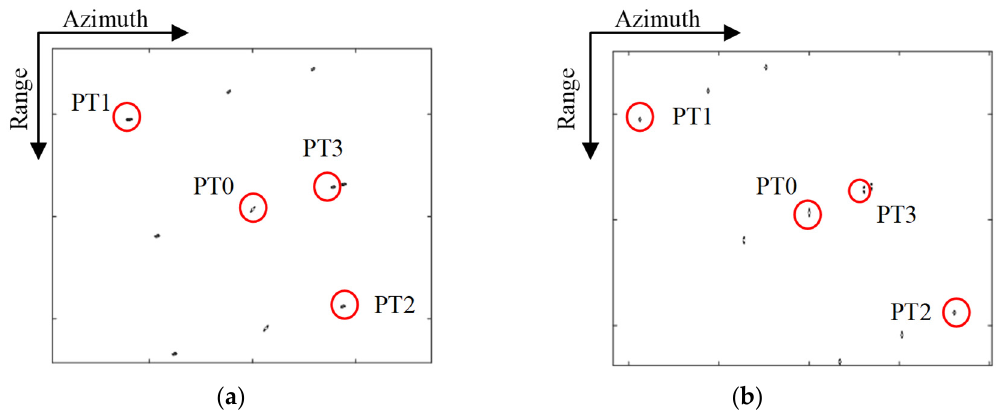
Figure 7. Imaging result of the whole scene. ( a ) CPFA; ( b ) EPFA.